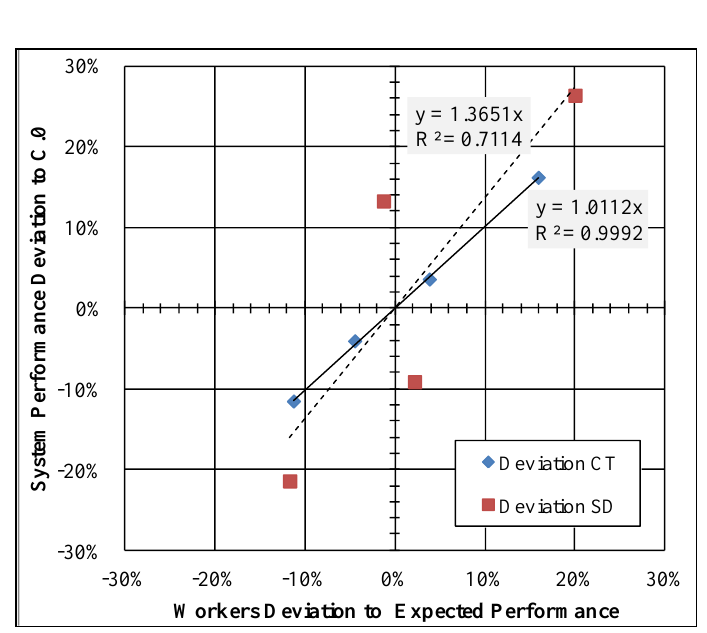
y = 1 . 3651x R ² = 0 .